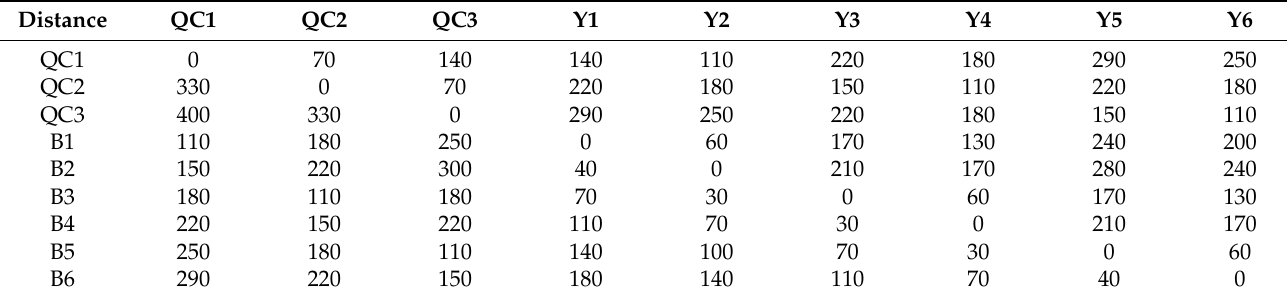
Table 4. Distance of AGV in each container interaction area.